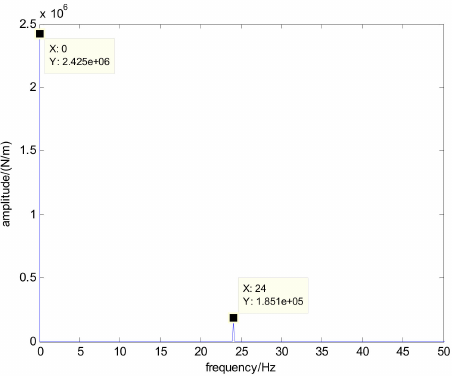
Figure 18. Square-axis rotor horizontal stiffness